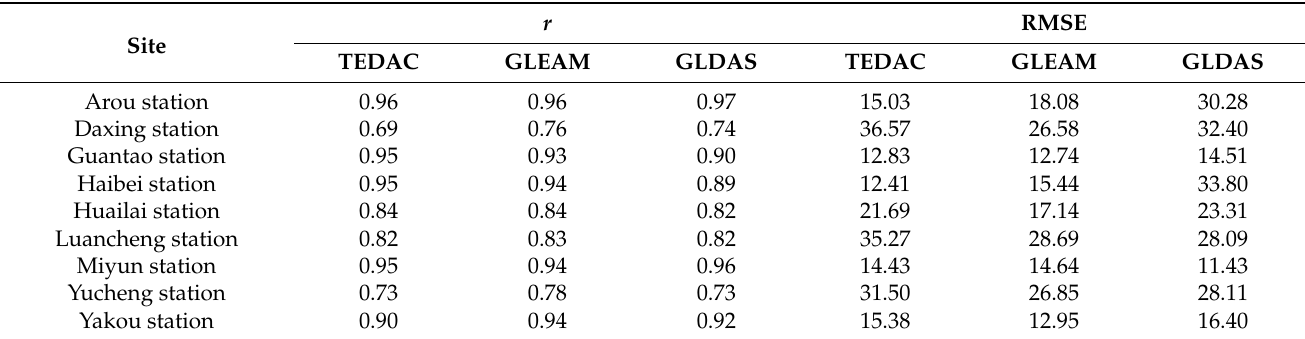
Table 2. Correlation coefficient and RMSE between the values of evapotranspiration products and the evapotranspiration at the flux